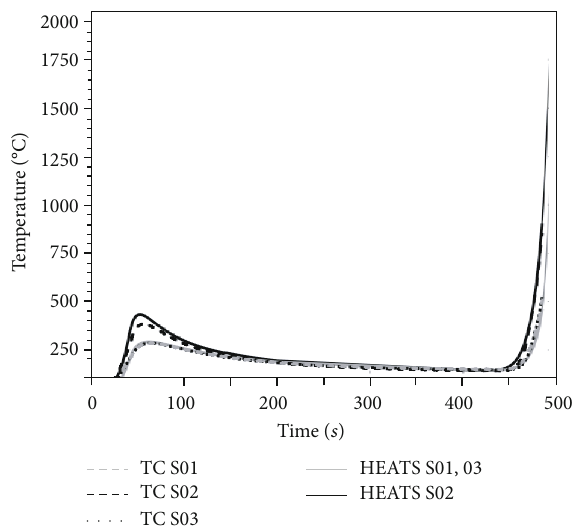
Figure 19: Comparison of HEATS results to SHEFEX II measurement of panels B and D.